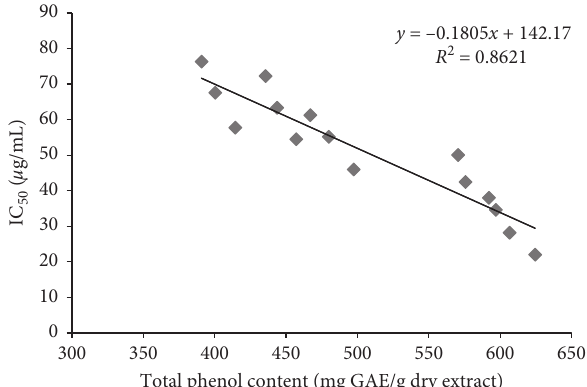
Figure 3: Correlation between total phenol content and IC